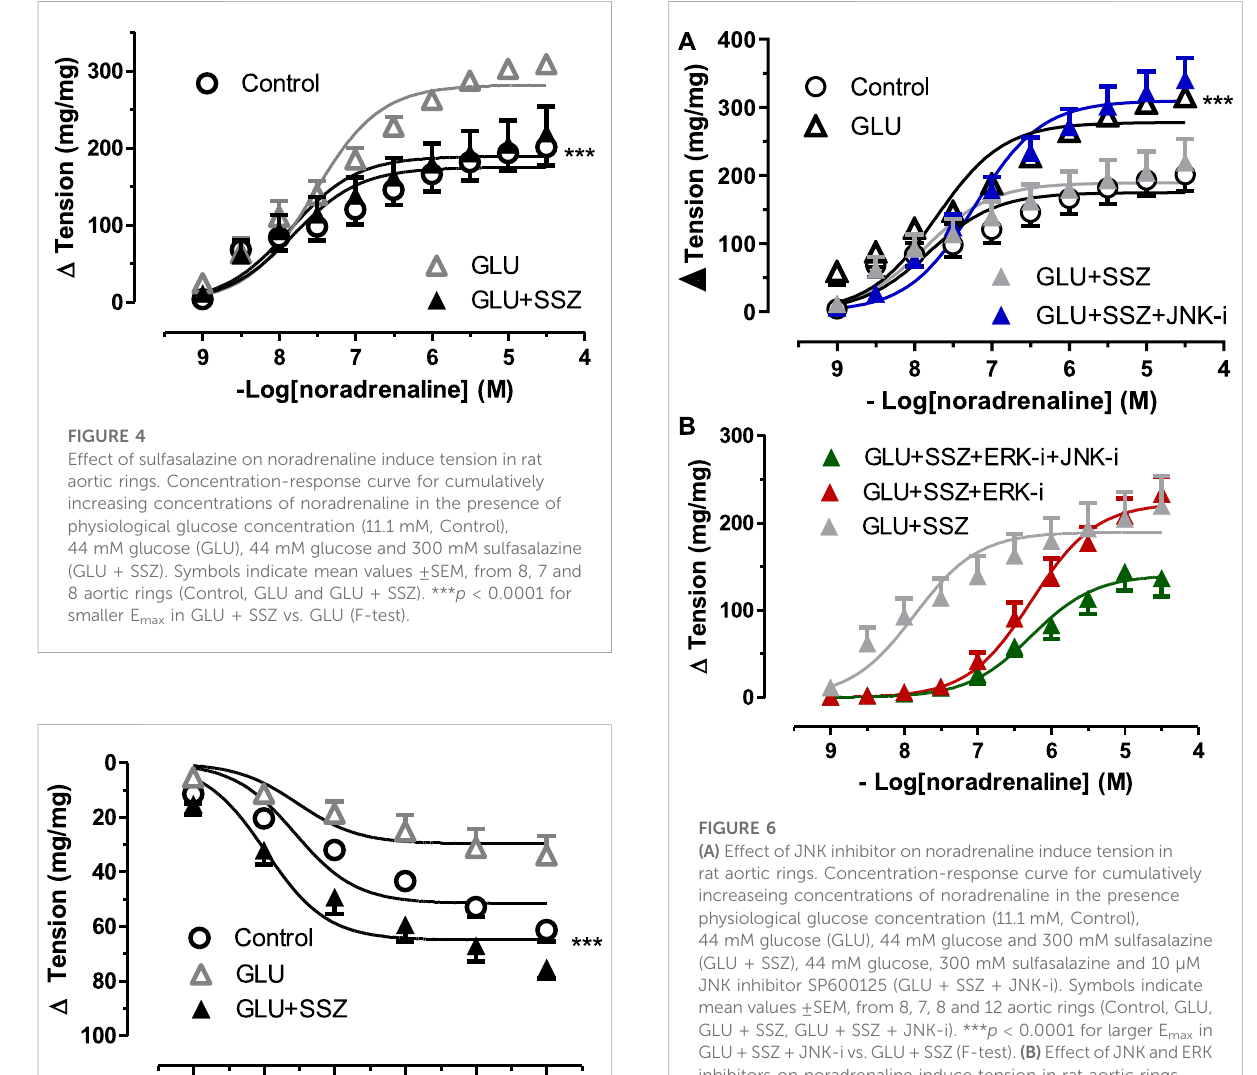
FIGURE 5 Effect of sulfasalazine on acetylcholine induce tension in rat aortic rings. Concentration-response curve for cumulatively increaseing concentrations of acetylcholine induced relatation in rat aortic rings, express as delta tension the presence of physiological glucose concentration (11.1 mM, Control), 44 mM glucose(GLU) andinthepresenceof44 mMglucose and300 mM sulfasalazine (GLU + SSZ). Symbols indicate mean values ±SEM, from 9, 12 and 11aorticrings (Control, GLU and GLU + SSZ). *** p < 0.0001 for smaller E max GLU + SSZ vs. Control (F-test).